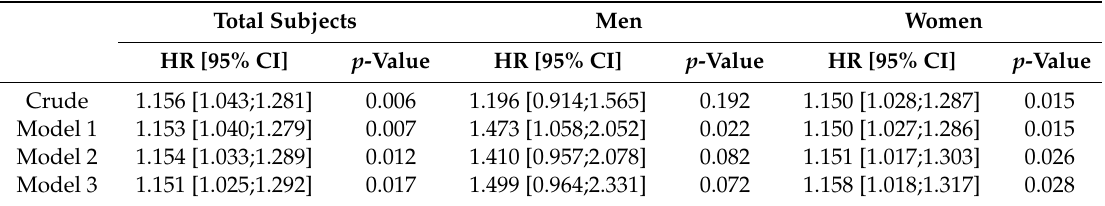
Table 2. Hazard ratio of serum uric acid for renal event with Cox proportional hazard models by sex. Total Subjects Men